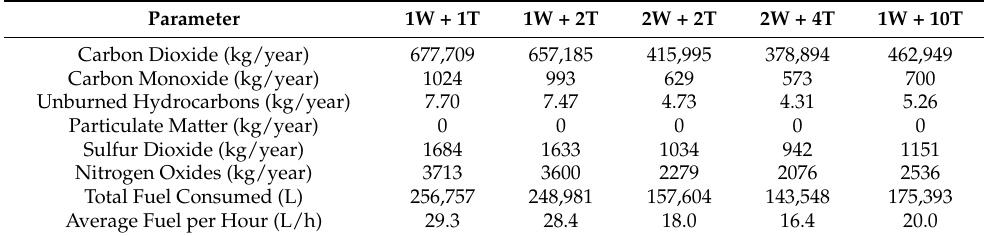
Table 13. Emissions of pollutants and fuel consumption.